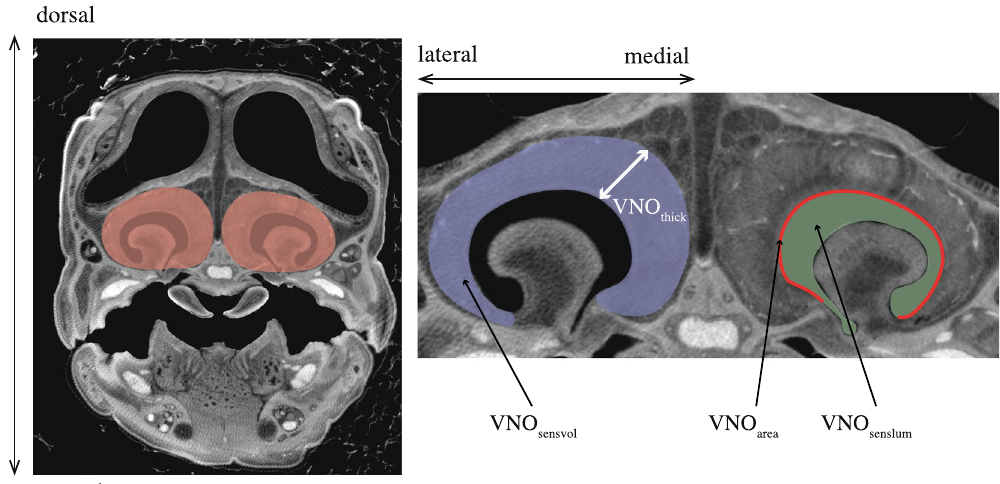
Figure 5. An example of reconstructed micro-CT images of a lacertid lizard head ( Takydromus sexlineatus ) highlighting the vomeronasal organs (VNOs). ( A ) transverse section of the complete head, with the VNOs in red; ( B ) transvers section focussing on the VNOs, with additional annotations on the measures used in this study. Abbreviations: VNO sensvol = volume of VNO sensory epithelium (blue), VNO senslum = volume of VNO lumen (green), VNO thick = thickness of VNO sensory epithelium (white line with arrows), VNO area = surface area of VNO sensory epithelium (red